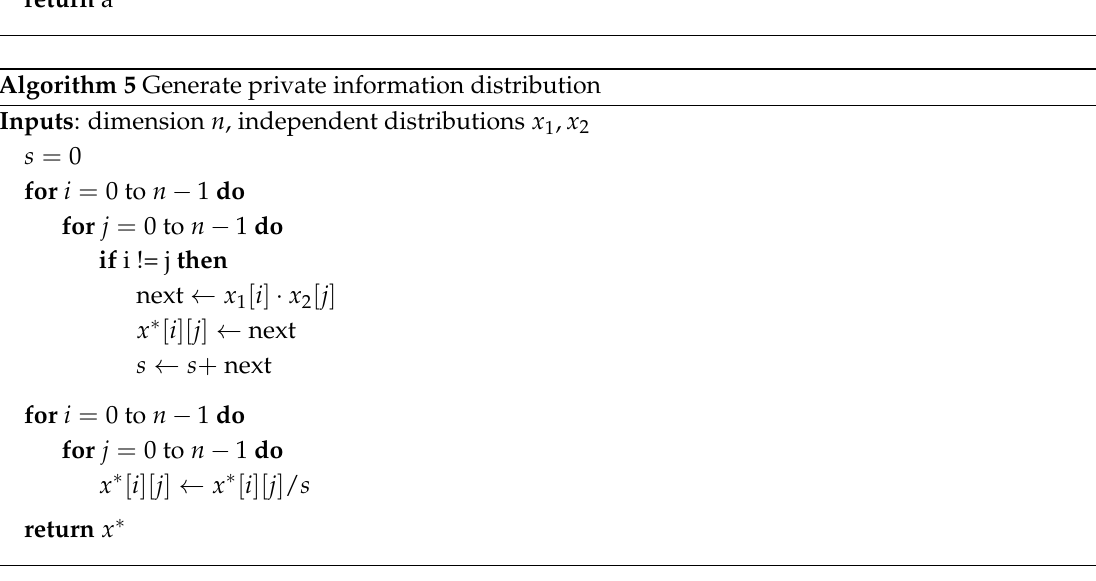
Algorithm 5 Generate private information